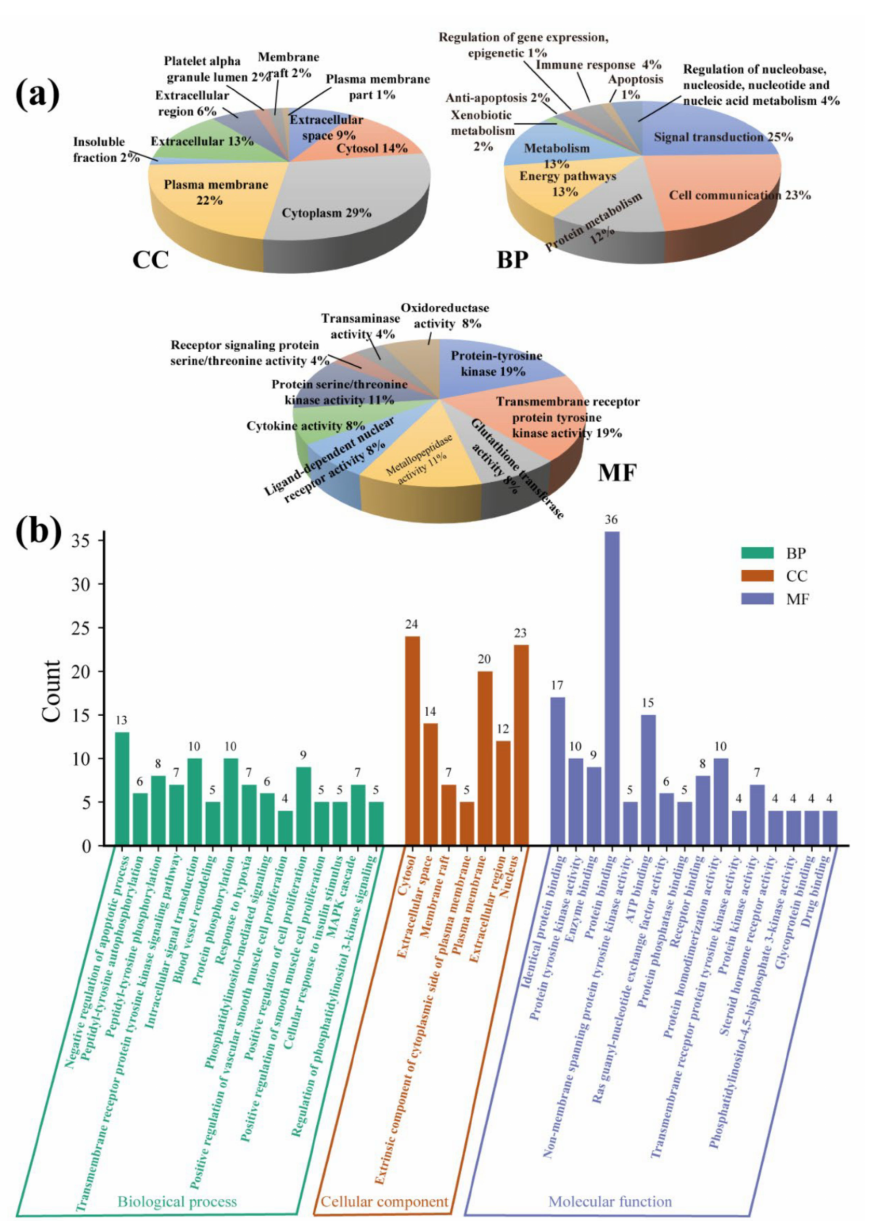
Figure 2. Hub targets GO (gene ontology) enrichment. ( a ) Analysis by the FunRich software (Ver. 3.1.3); ( b ) analysis by the DAVID database (Ver. 6.8) with a p -value <